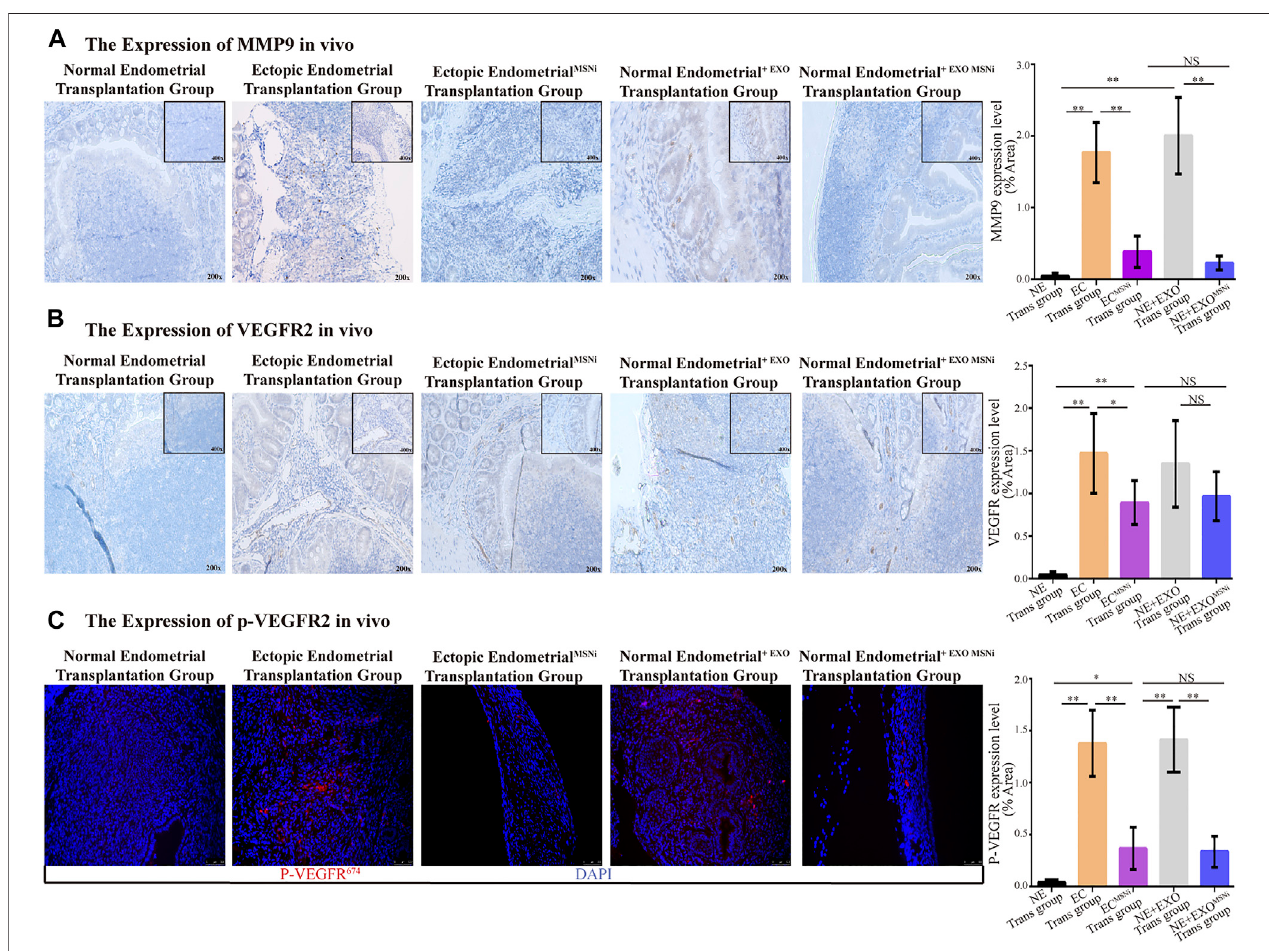
FIGURE6| Exosome MSN increasedtheexpressionofMMP9,VEGFR2andp-VEGFR2 invivo . (A) MMP9expressedinectopicimplanttissuesdetectedbyIHC. (B) VEGFR2 expressed in ectopic implant tissues detected by IHC. (C) Immuno fl uorescence of p-VEGFR2 in ectopic foci. The result was consistent with VEGFR2. MSNi: MSN siRNA transfection; Microscopic magni fi cation: ×200. **, p < 0.001; *, p < 0.05; NS, no signi fi cance.